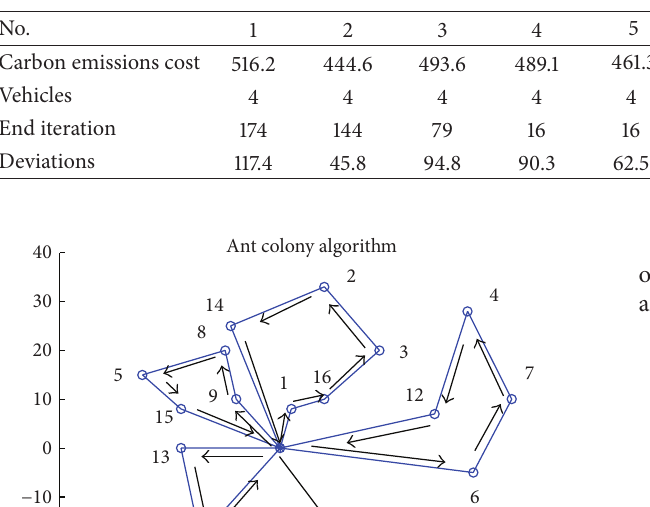
Table 4: The results of DNA-ant colony algorithm (minimum carbon emissions cost).